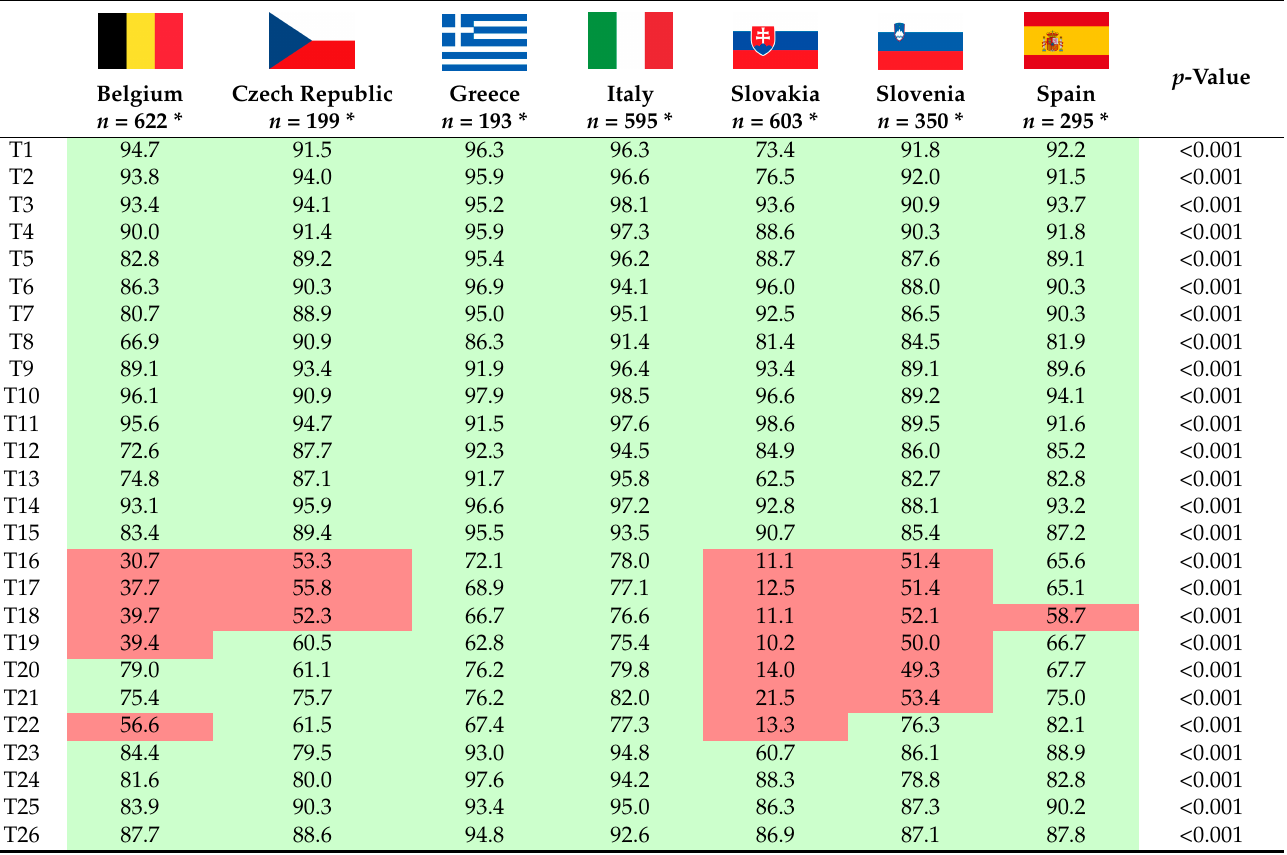
Table 5 . Presentation of 26 tasks within seven $ pharmaceutical care domains considered to be nurses’ tasks in order to obtain best quality of care and patient outcomes by at least 60% of the respondents, split up for 7 countries.